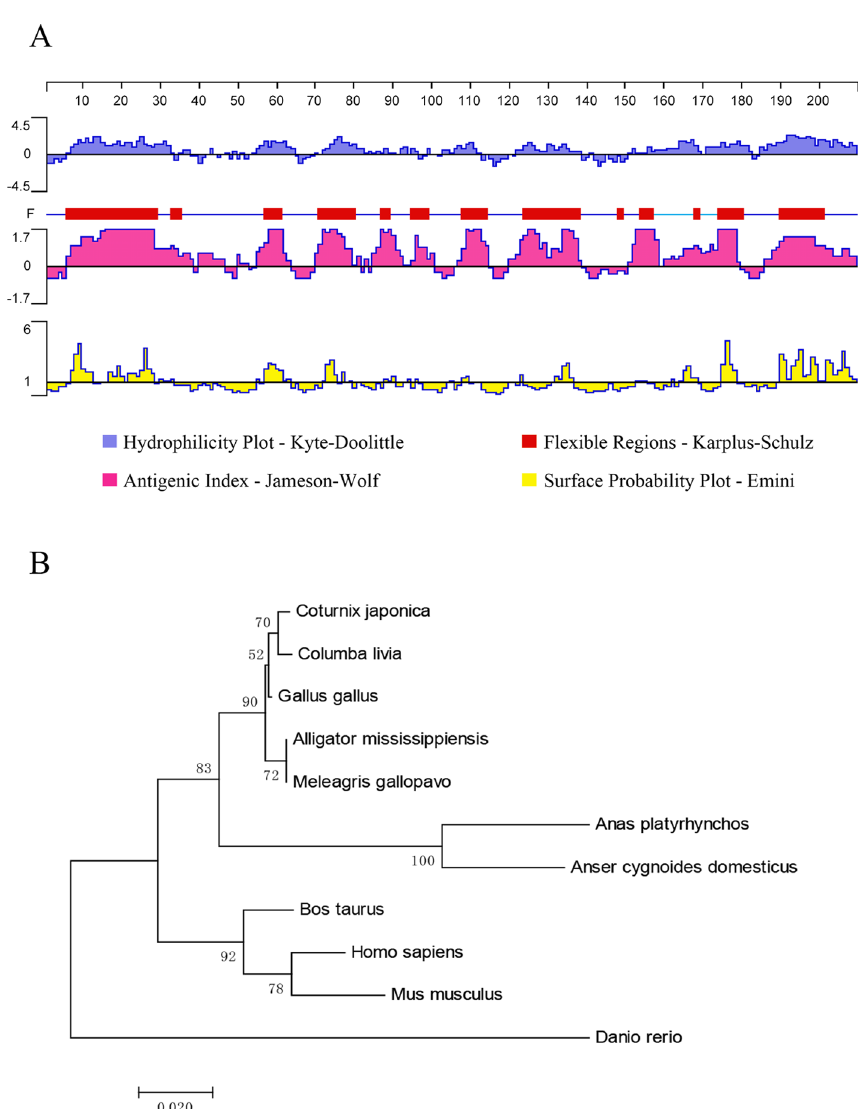
Figure 4. (A) Linear-B cell epitopes of UBE2F predicted by DNASTAR are shown in hydrophilicity plots, fl exible regions, antigenic indices, and surface probability rules. (B) The phylogenetic tree of amino acid sequences of UBE2F in poultry and